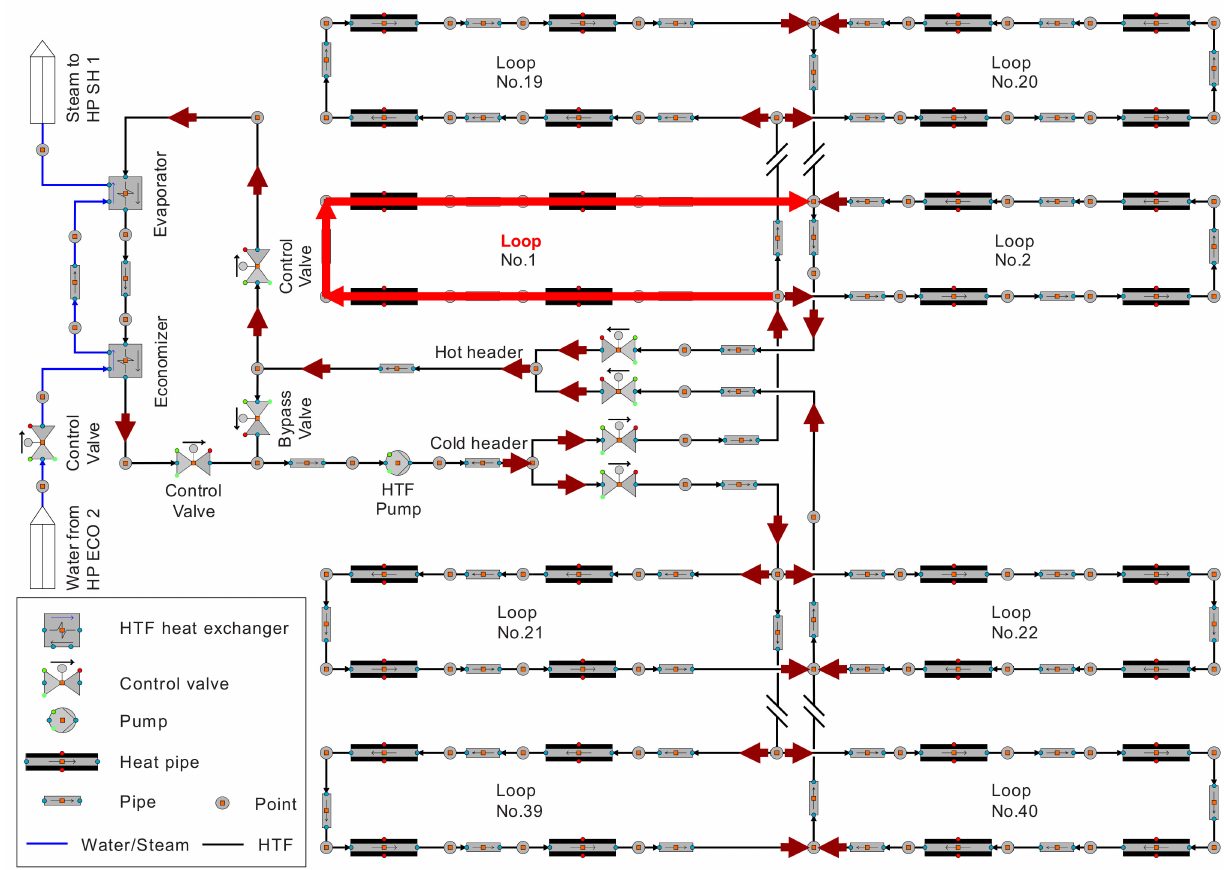
Figure 5. Schematic of the solar field net in